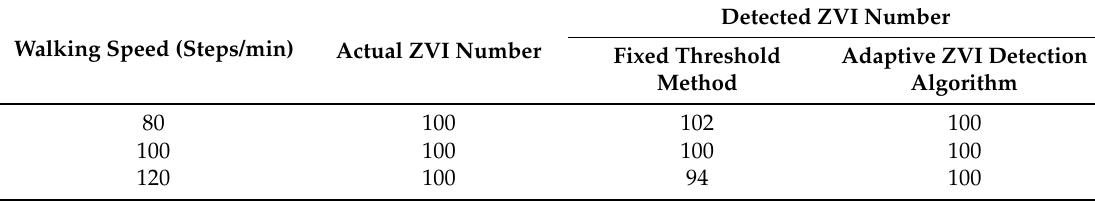
Table 1. ZVI detection results at different walking speeds.